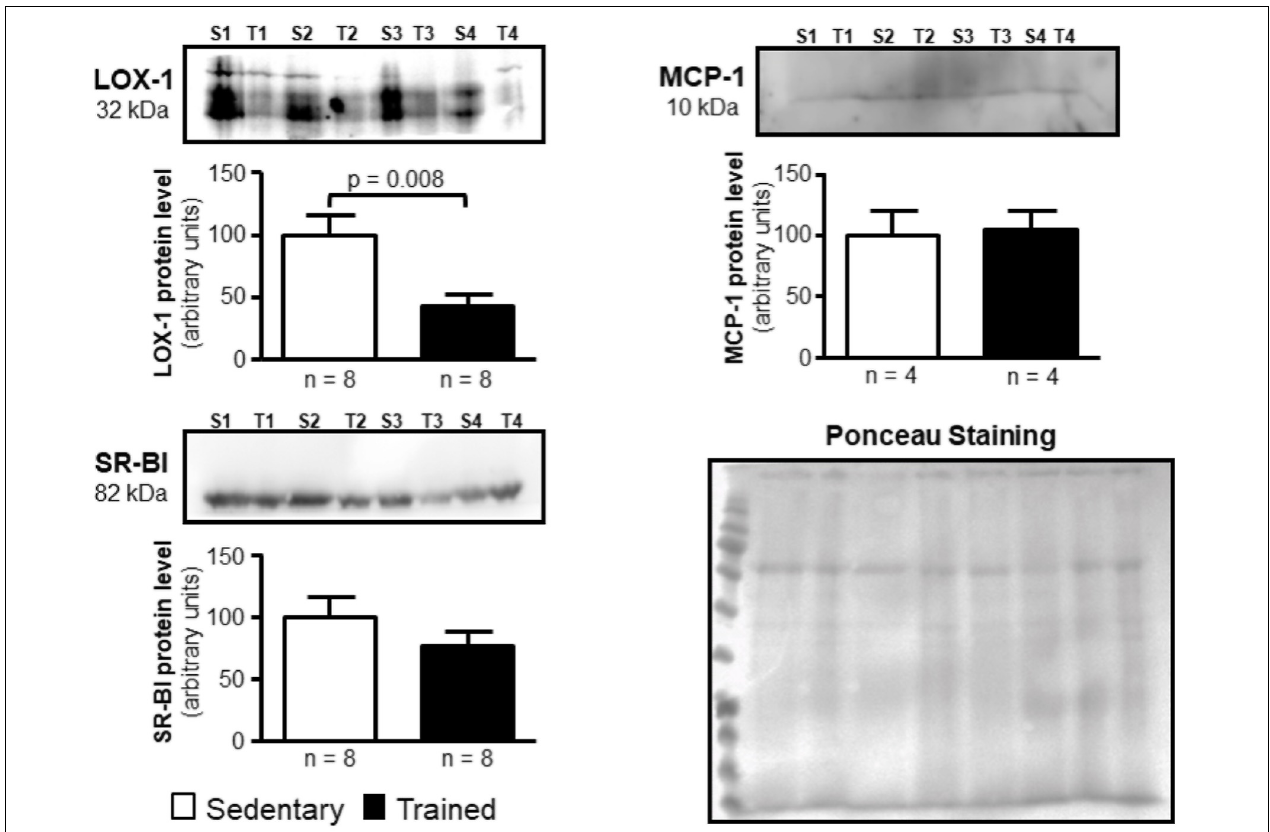
FIGURE 5 | Expression of LOX-1, MCP-1, and SR-BI in the arterial wall of sedentary (S) and trained (T) animals. Immunoblot was performed by utilizing 40 µ g of total protein from the aortic arch of S and T animals after 48 h of the last exercise session in order to confirm results obtained by RT-qPCR. Immunoblot was performed by using anti-LOX-1 (1:100); anti-MCP-1 (1:1000), anti-SR-BI (1:1000) and anti-ABCA-1 (1:50; not visualized) primary antibodies and horseradish peroxidase-linked secondary antibody (see section Materials and Methods for more details). The band densities of the respective lanes, stained by Ponceau, were used for normalization. The results were expressed as arbitrary units, related to mean of the sedentary animals, which was set as 100. Comparisons were done by the unpaired Student t -test (mean ± SEM). Representative images ( n = 4–8, as